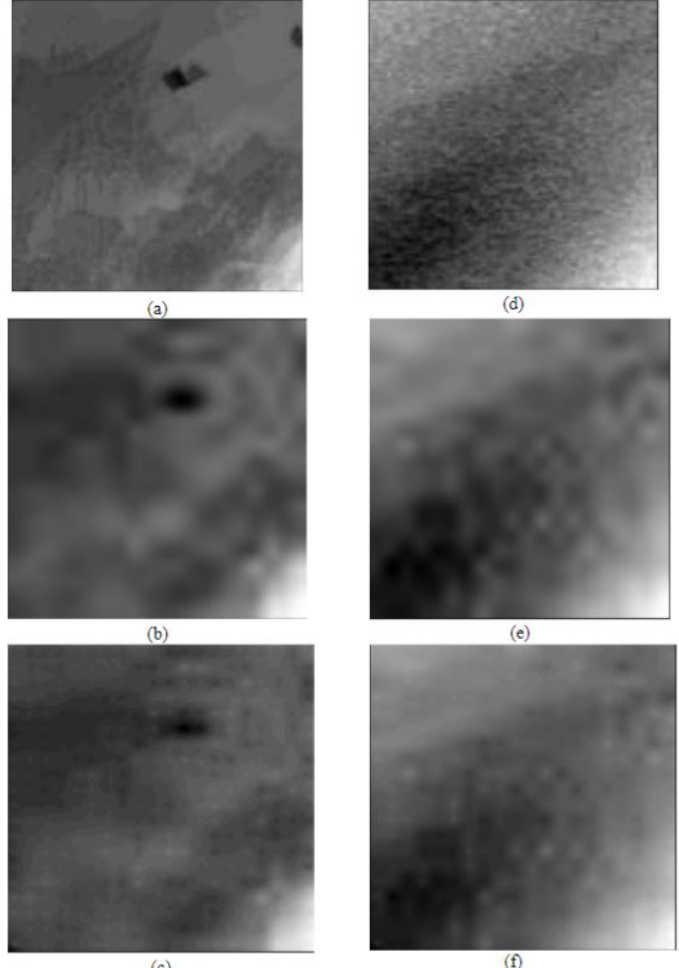
Figure 7. Simple textured images: Deep machine learning-based RTISR with the residual neural network and conventional bicubic upscaling: ( a ) Original image; ( b ) Bicubic upsampled image of ( a ) [SSIM: 0.0105]; ( c ) Deep machine learning based RTISR of ( a ) [SSIM: 0.9815]; ( d ) Original image; ( e ) Bicubic upsampled image of ( d ) [SSIM: 0.0077]; ( f ) Deep machine learning based RTISR of ( d ) [SSIM: